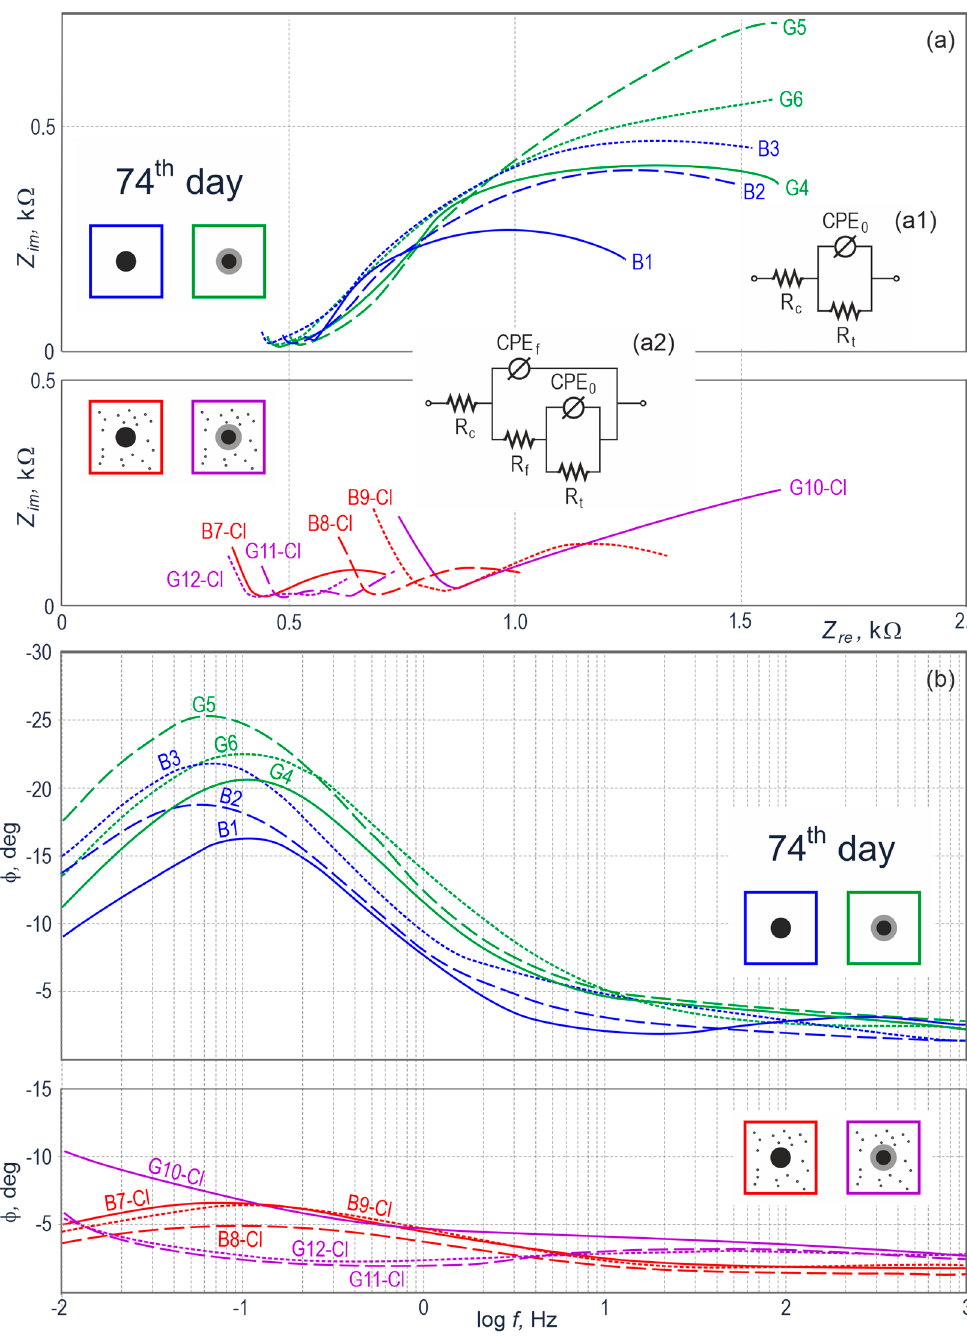
Figure 7. Results from impedance testing of steel reinforcement in concrete from 12 specimens on day 74 of measurements illustrated at the Nyquist ( a ) and Bode ( b ) plots, B —black steel in concrete without additives, G —galvanized steel in concrete without additives, B-Cl —black steel in concrete with chlorides, and G-Cl —galvanized steel in concrete with chlorides; ( a1 ) electrical equivalent circuit for the B and G spectrum groups, ( a2 ) electrical equivalent circuit for the B-Cl and G-Cl spectrum groups